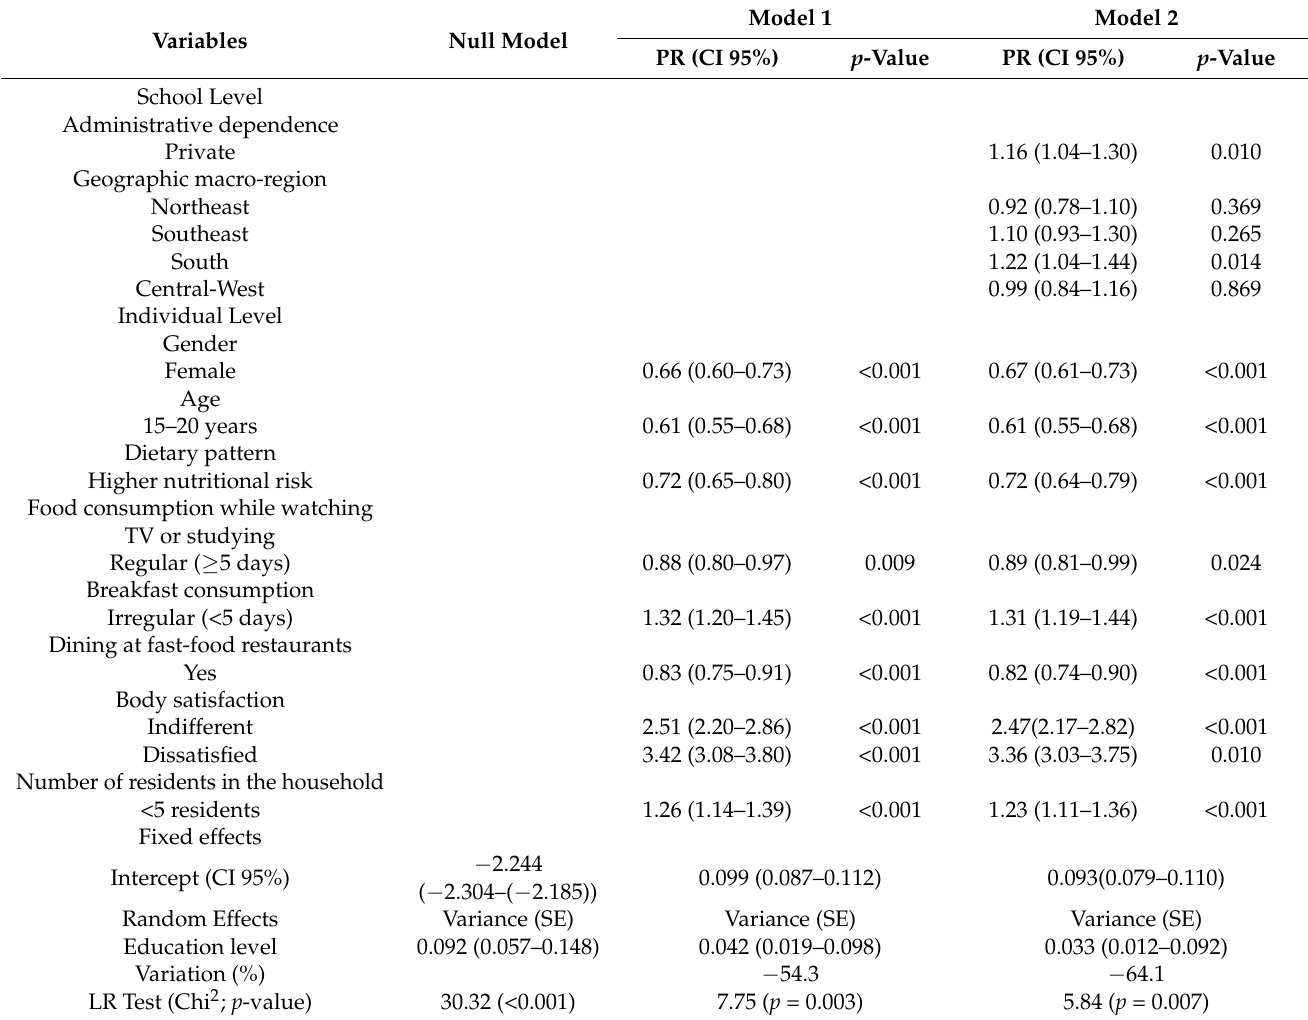
Table 3. Multilevel regression of obesity among Brazilian adolescents and individual- and school-level variables, National School Health Survey,